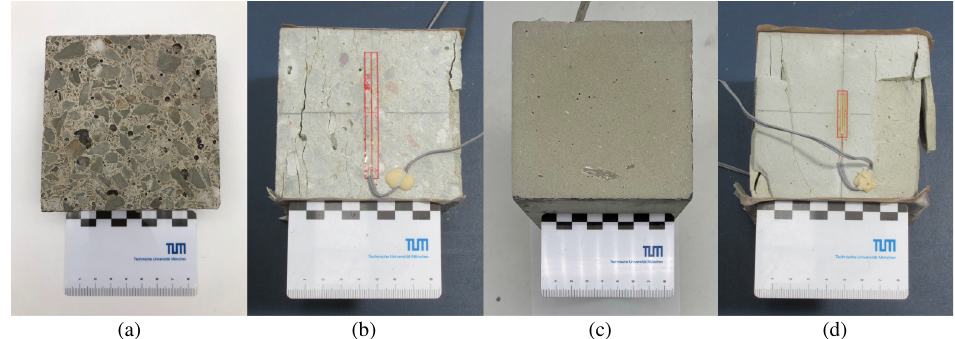
Figure 3. Determination of material parameters for concrete and cement paste: ( a ) polished concrete specimen with a maximum grain size of 16 mm before loading, ( b ) cracked concrete specimen with a strain gauge after the compressive load test, ( c ) polished hardened cement paste specimen before loading, ( d ) hardened cement paste specimen with strain gauge after the compressive load